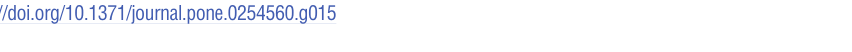
Fig 15. The confusion matrices generated for each algorithm. The confusion matrices obtained by implementing the four signal processing algorithms can be observed.